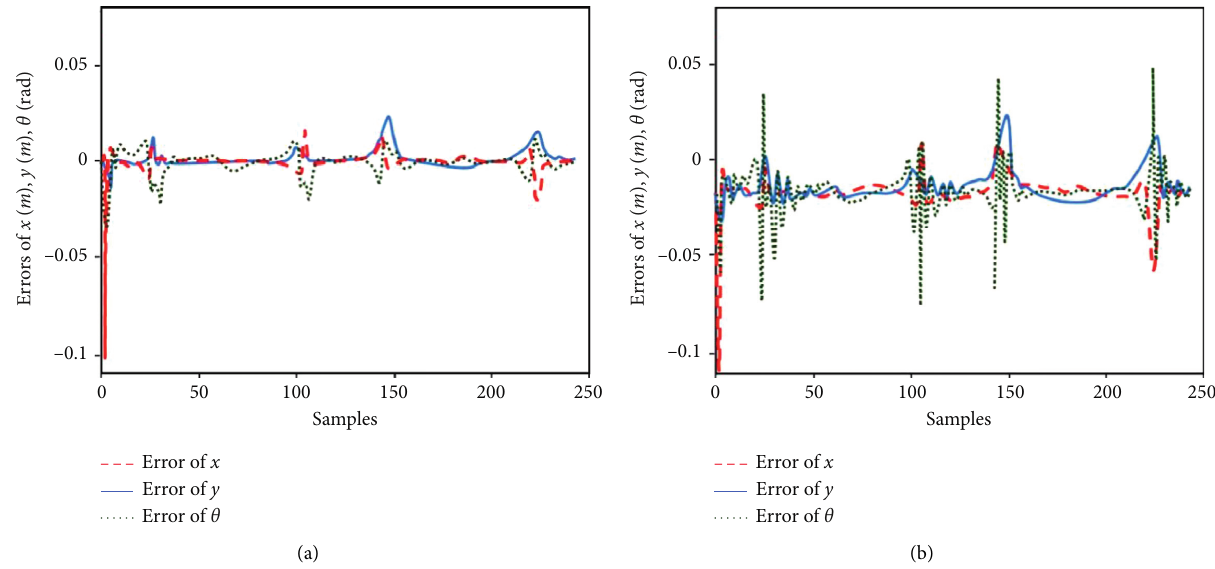
Figure 12: The error of x and y coordinates and orientation θ of DDMR for lemniscates trajectory with (a) NNFOPID controller and (b) NNPID controller.